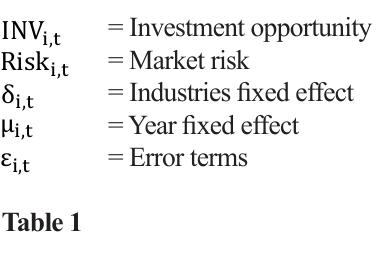
Definition and Proxy of Variables Constructs Represent b y Dividend